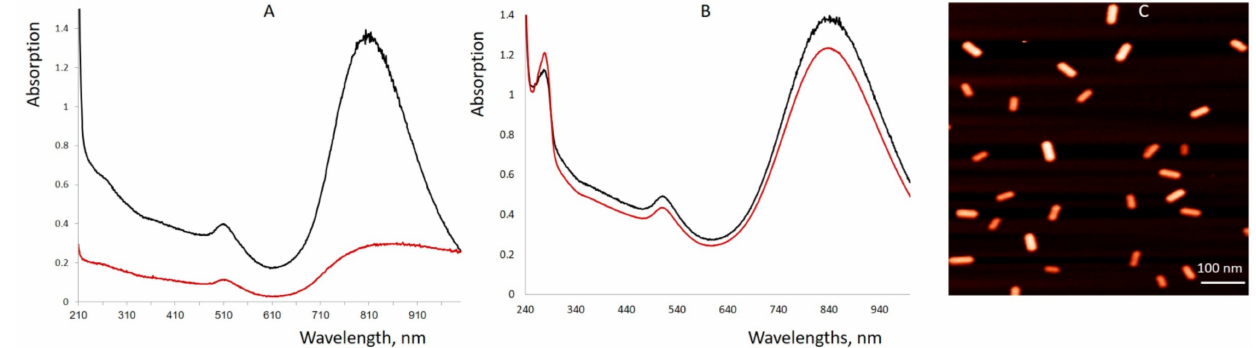
Figure 2. Absorption spectra ( A , B ) and AFM image ( C ) of DARPin-GNRs ( A ) and DARPin-BSA-GNRs ( B , C ). ( A , B ): The nanorods were incubated for 1 h at 37 ◦ C in water (black curves) and in 1 M NaCl (red curves). ( C ): AFM was performed on molecules adsorbed on muscovite mica as described in